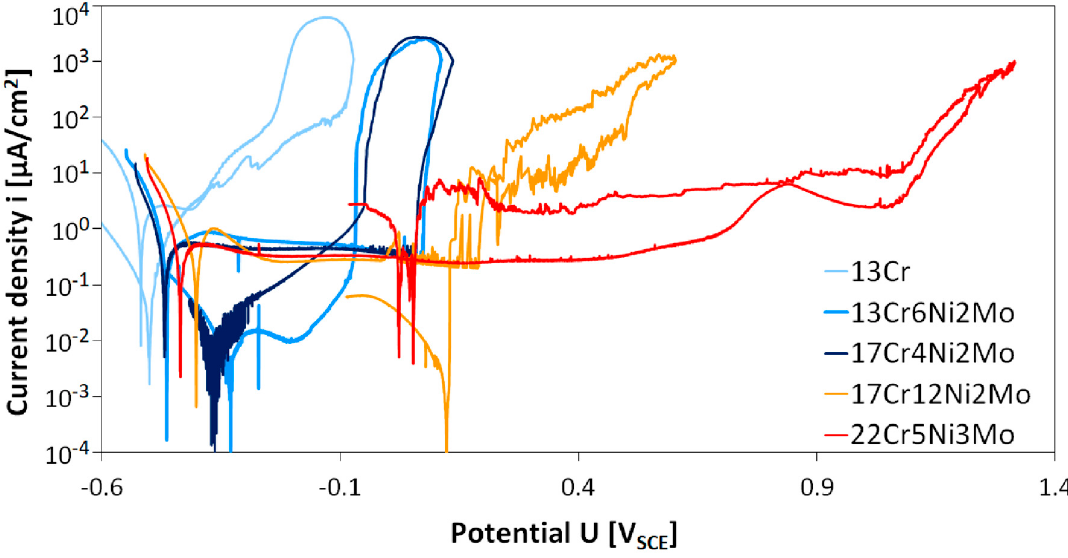
Figure 2. Potentiodynamic measurements of investigated stainless steels in 30,000 ppm Cl – (as NaCl), 30 °C, 1 bar CO 2 , 200 mV/h.